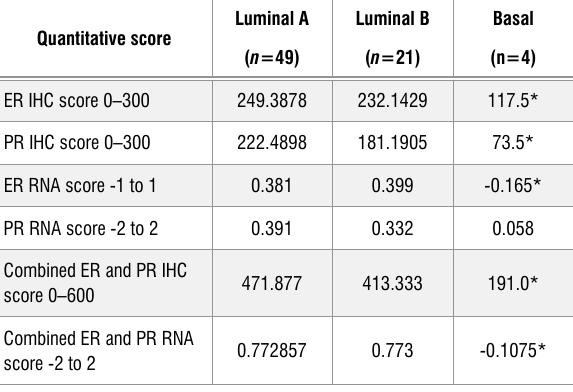
Flow diagram showing the relationship of and TargetPrint